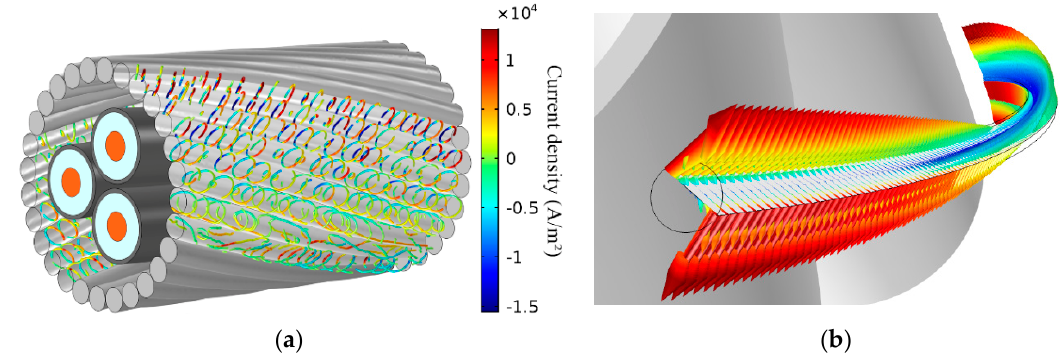
Figure 9. ( a ) Eddy currents circulating inside the armor wires in Cable 1; ( b ) Direction of the flowing path of eddy currents inside a portion of an armor wire in Cable 1.